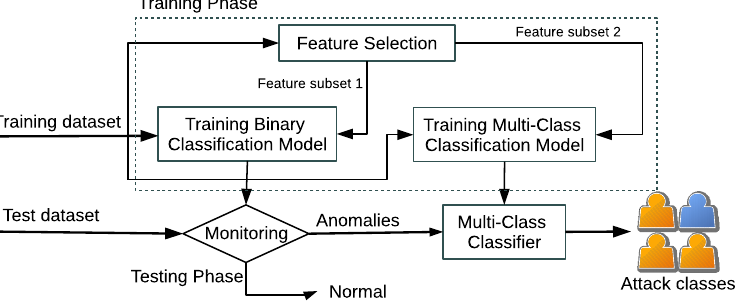
Figure 1. Framework of